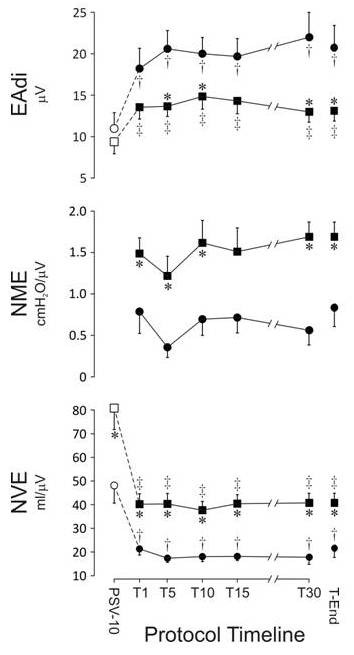
The development of (top to bottom) diaphragm electrical activity (EAdi), neuromechanical efficiency (NVE), and neuroventilatory efficiency (NME) during pressure support of 10 above 5 cm H2O of PEEP (PSV10) and throughout the spontaneous breathing trial (SBT) on CPAP of 5 cm H2O. On the X-axis: T1, T5, T10, T15, T30, and Tend indicate minutes 1, 5, 10, 15, and 30, as well as the last data obtained during the SBT. In the successfully extubated group, n = 35 at all time points. In the group for whom extubation failed, n = 17 at PSV10, T1, and T5; n=16 at T10 and T15; n=14 at T30 (three for whom SBT failed at 30 minutes and 11 who were initially extubated but were later reintubated or provided with noninvasive ventilation or died). Data were obtained for the remaining three patients meeting SBT exclusion criteria at T30. At Tend, n = 17 in the group for whom extubation failed. *Difference (P < 0.05) between failure and successfully extubated groups at the same time point. †Differences (P < 0.05) between PSV10 and other time points in the group for whom extubation failed. ‡Differences (P < 0.05) between PSV10 and other time points in the group that was successfully extubated.